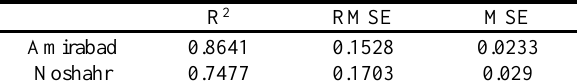
Table 2. Numerical results for Amirabad and Noshahr ports.